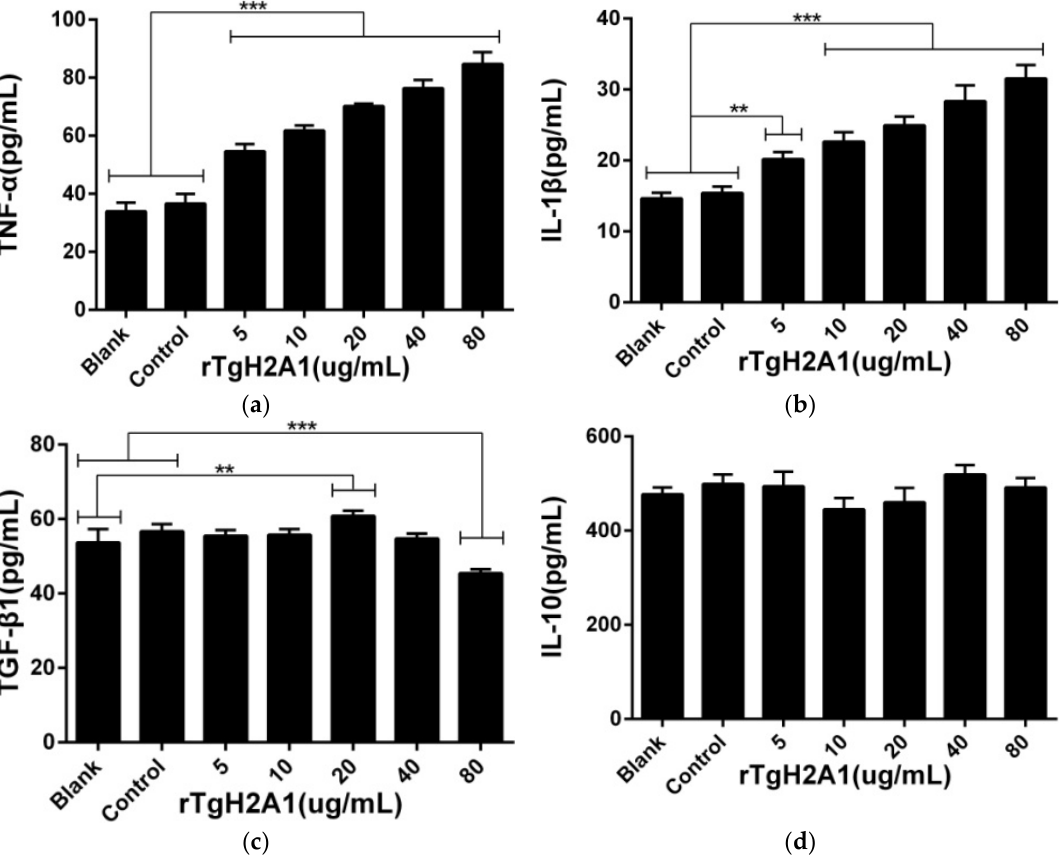
Figure 6. rTgH2A1 induced cytokine secretion of the murine macrophages in vitro. Preincubated with different concentrations (0, 5, 10, 20, 40, and 80 μg/mL) of rTgH2A1 for 48 h, cytokine secretion was determined by commercial kits based on the double antibody sandwich method. The Ana-1 cells in the blank groups were treated with PBS while the control group was treated with his-tagged protein. Results were evaluated using one-way ANOVA analysis followed by Dunnett’s test, and values were displayed as mean ± standard deviation from three independent experiments. ** p < 0.01, and *** p < 0.001 compared with the blank group or control group. Effect of rTgH2A1 on the TNF-α ( a ), IL-1β ( b ), TGF-β1 ( c ), and IL-10 ( d ) secretion of murine Ana-1 cells was determined.